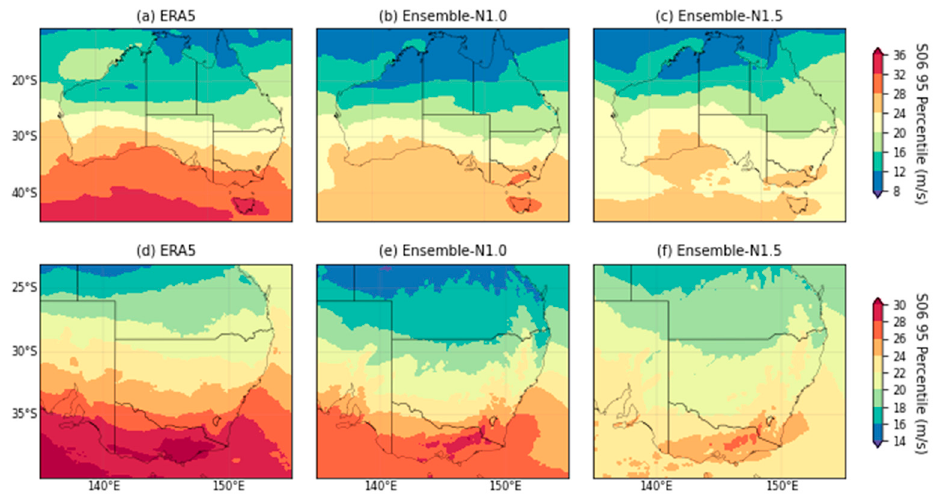
Figure 11. As in Figure 9 except for S06. Unit: m s − 1 .